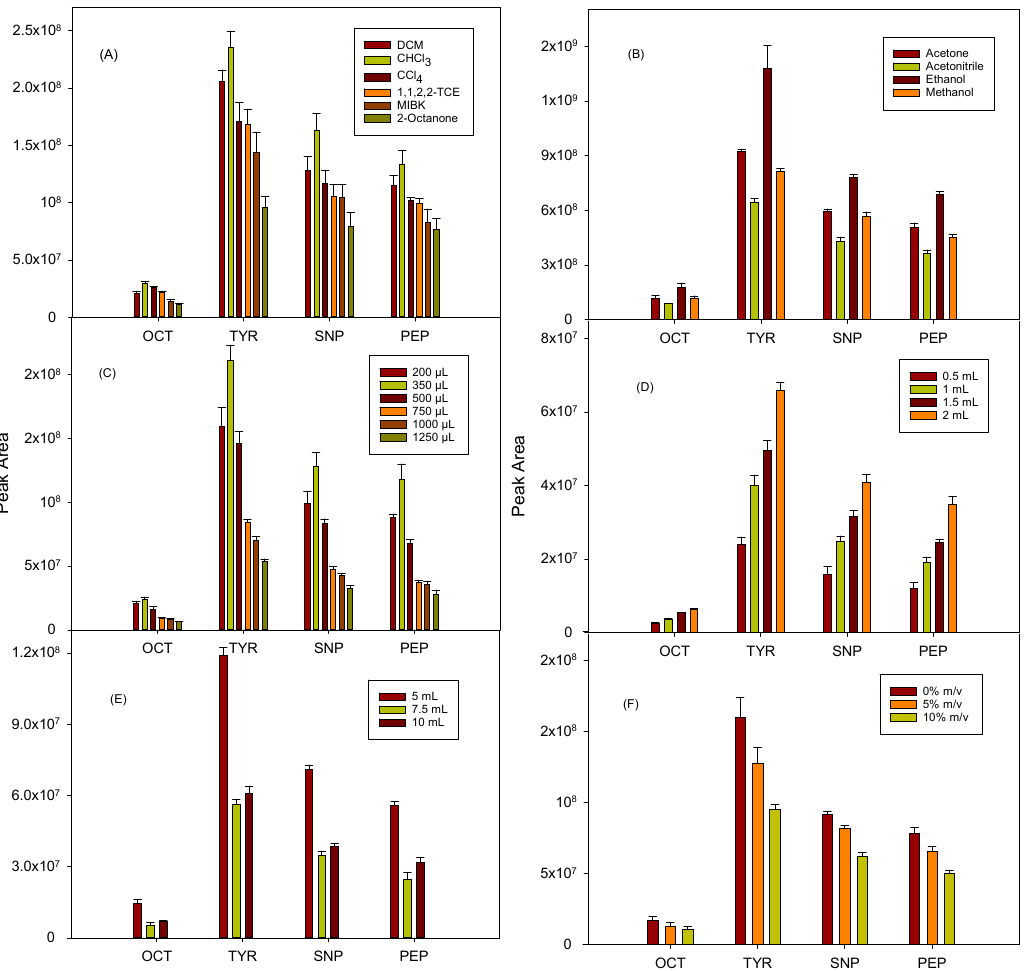
Figure 1. Effect of experimental variables (n = 3) on extraction efficiency: ( A ) nature of extractant solvent, ( B ) nature of dispersant solvent, ( C ) extractant volume, ( D ) dispersant volume, ( E ) sample volume, and ( F ) NaCl concentration.